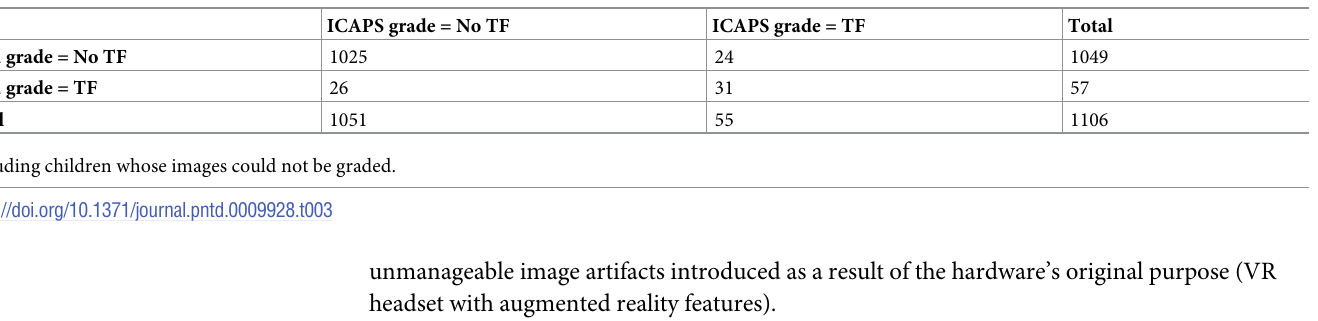
Table 3. Comparison of ICAPS grade to field grade for 1106 children with gradable images in survey.